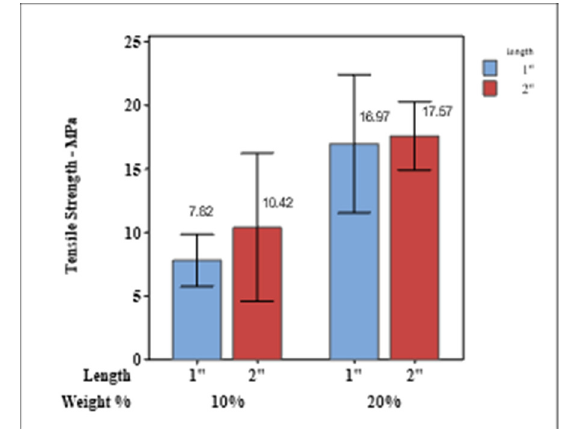
Fig. 5: Comparison of tensile strength of bagasse- reinforced composites